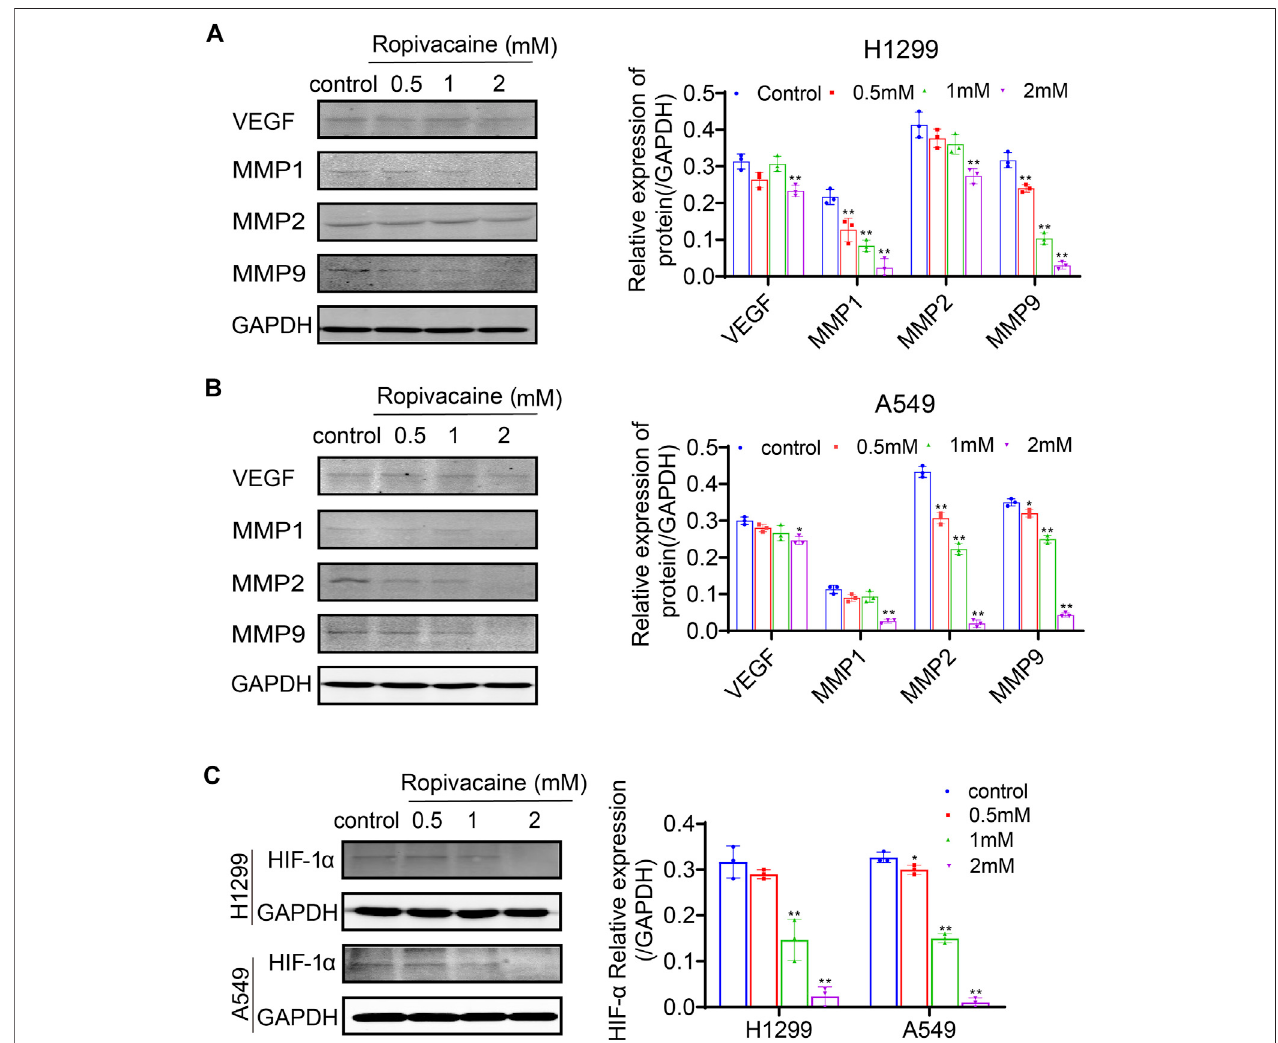
FIGURE 4 | RopivacainetreatmentreducedexpressionofVEGF,MMPs,andHIF-1 α inlungcancercells. (A) H1299cellsand (B) A549cellsweretreatedwithropivacaine (0.5,1,or2 mM)for48 h.Thecontrolgroupwastreatedwithano-FBSmediumfor48 h.VEGF,MMP-1,MMP-2andMMP-9proteinsinthecelllysateswereassayedbywestern blot. GAPDH proteins were used as internalcontrols. (C) H1299 and A549 cells were treated with ropivacaine (0.5, 1, or 2 mM) and CoCl 2 (100 μ M) for 48 h. The control group was treated with a no-FBS medium and CoCl 2 (100 μ M) for 48 h. The protein expression of HIF-1 α in H1299 cells and A549 cells was measured by western blot. The independent experiments were repeated three times. The data are expressed as the mean ± SD from three independent experiments. * p < 0.05, ** p < 0.01 vs. controls.